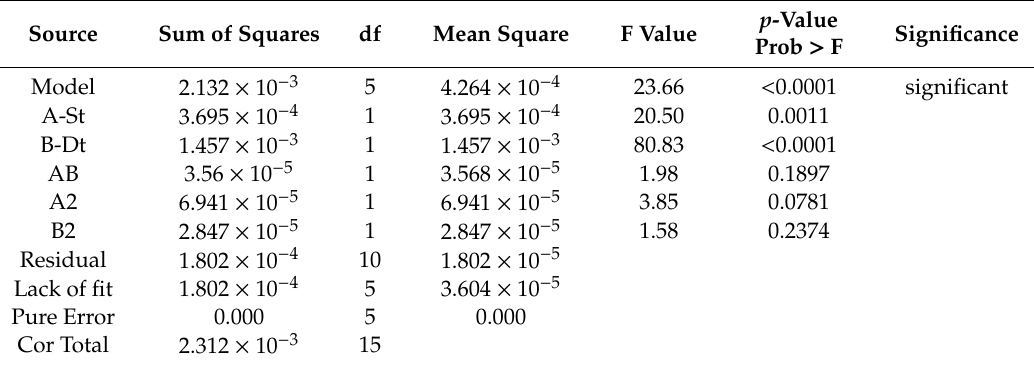
Table 6. ANOVA for density.